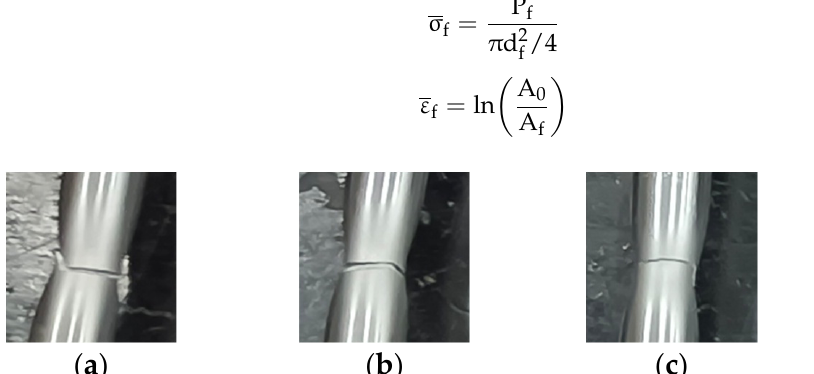
Figure 2. Fracture topography of smooth round bars: ( a ) RS-1, ( b ) RS-2, ( c ) RS-3.